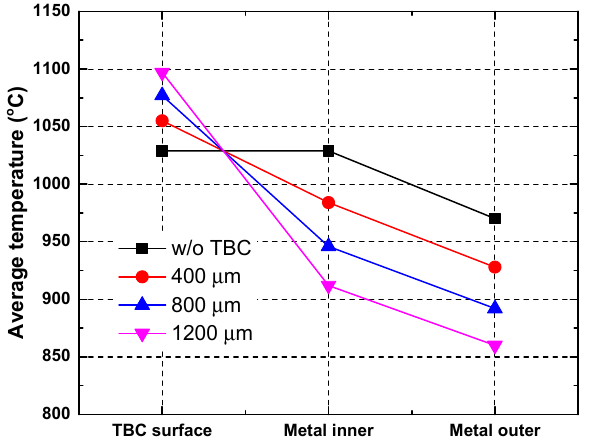
Figure 14. Average wall temperature of all surfaces based on the TBC thickness. between the TBC thicknesses. This is due to the low thermal conductivity of the YSZ ma- terial coated inside the CL, which slows the thermal conduction rate from the TBC surface to the inner metal surface, and the 𝑑𝑇 can, thereby, provide a thermal barrier to the CL. As a result of the effectiveness of varying TBC thicknesses, a total temperature reduction between the TBC surface and the outer metal was increased. Additionally, the 𝑑𝑇 com- parison of all three TBC thickness cases with no TBC thickness case is shown in Figure 17. As previously stated, the inner and outer metal temperature decreased as the TBC thick- ness increased, which increased the 𝑑𝑇 of the inner and outer metal between without TBC and TBC thickness, as shown in Figure 17. The percentage of decrease in the inner metal temperature based on TBC was calculated using Equation (9), and it is shown in Figure 18: